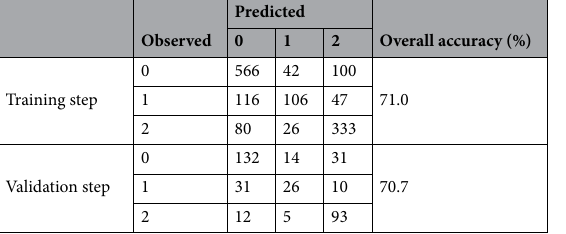
Table 5. Accuracy results of the susceptibility prediction model of landslides based on KDE-MLR.